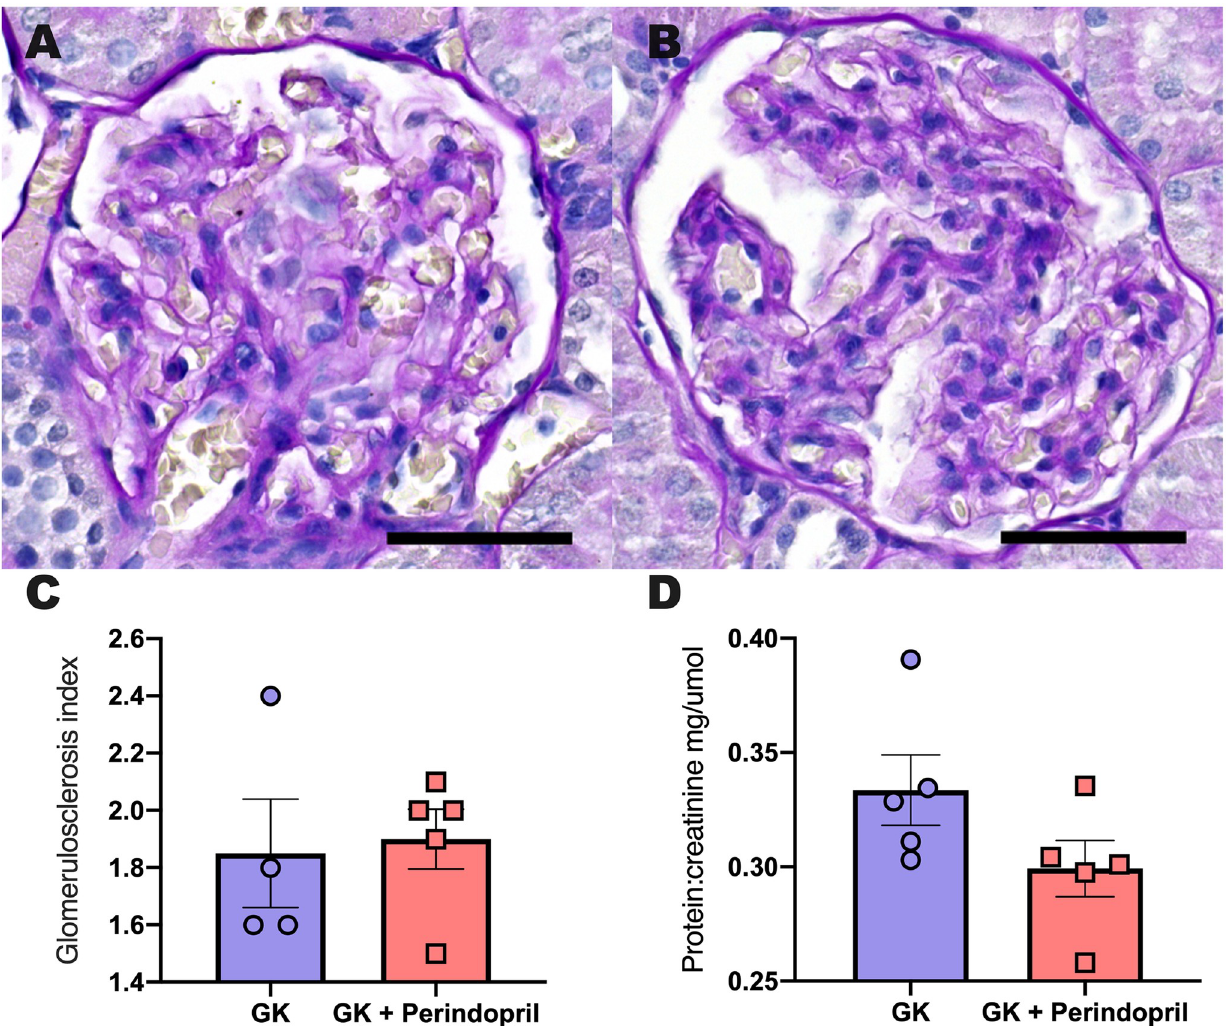
Fig 8. Kidney Structure and function in control GK rats and GK rats treated with perindopril. Representative PAS images of and Goto Kakizaki rats (A) and Goto Kakizaki rats treated with Angiotensin Converting enzyme inhibitor perindopril (B), respectively. Glomerulus score index (C) and analysis of protein; creatine (D) following treatment. Parameters were measured in Goto Kakizaki rats either treated with saline (GK) or ACE inhibitor perindopril (GK + perindopril). a student’s t-test was used to compare groups and no significant difference was identified. Data is expressed as mean ± SEM N = 4–5 per group. Scale bars 50 μ